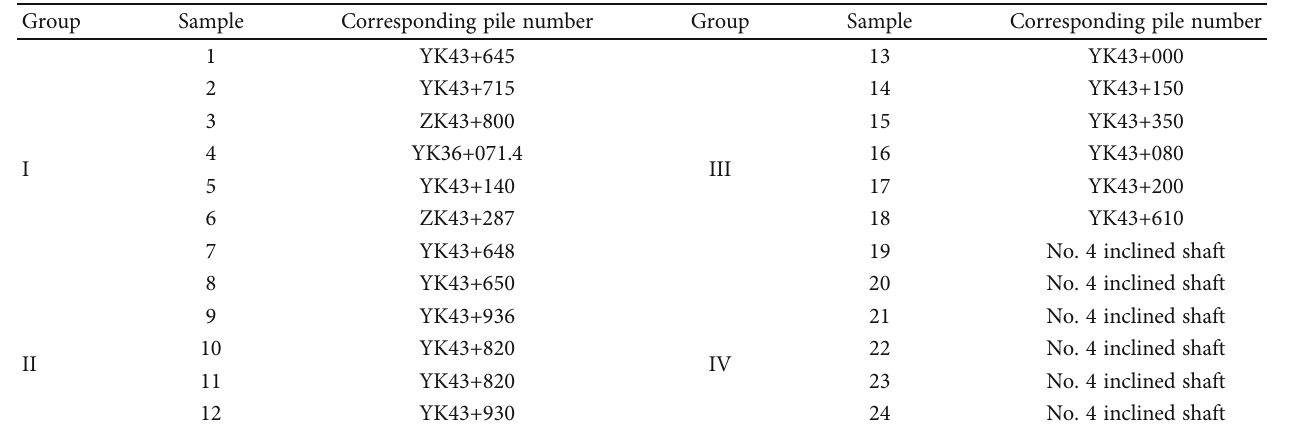
Figure 4: Schematic diagram of sampling points. Table 1: Sample points corresponding to pile